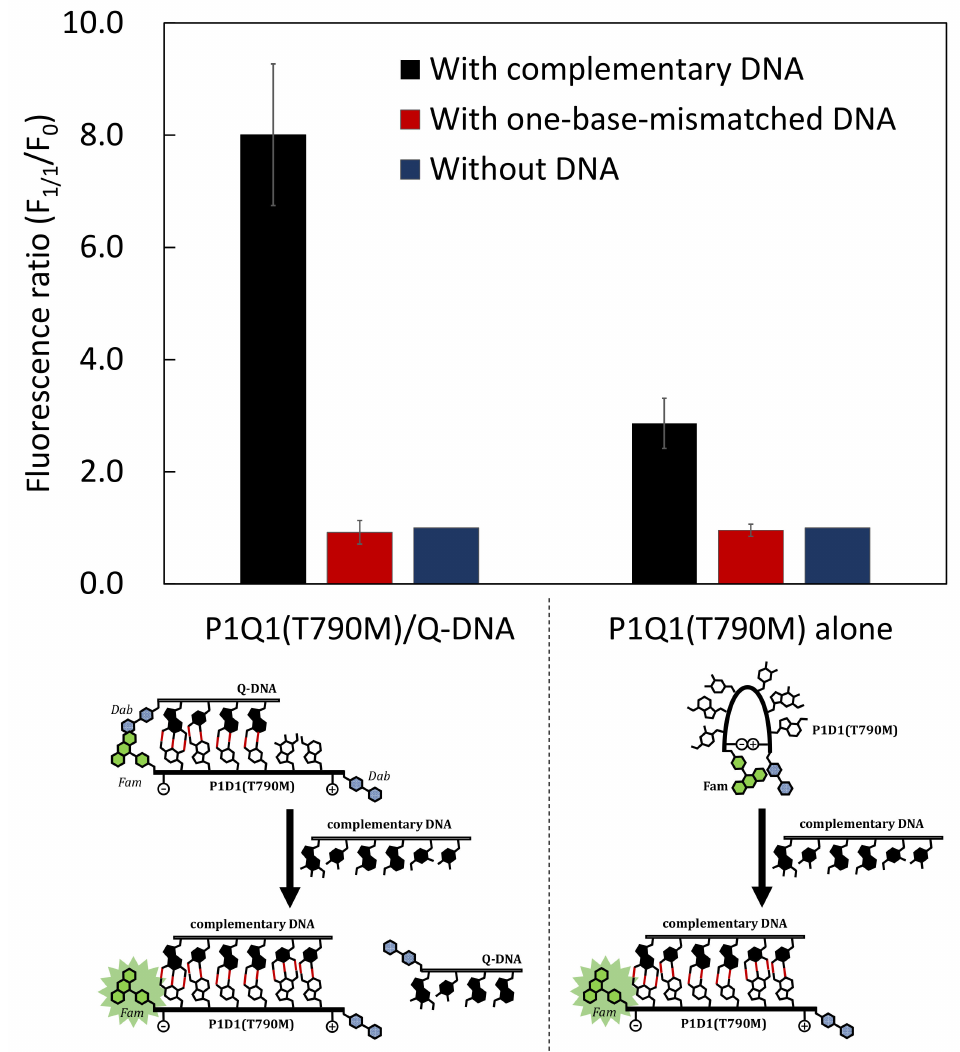
Figure 7. Fluorescence ratios (F 1/1 /F 0 ) of 1:1 mixtures of P1Q1(T790M) /Q-DNA hybrid with DNAs, and of P1Q1(T790) with